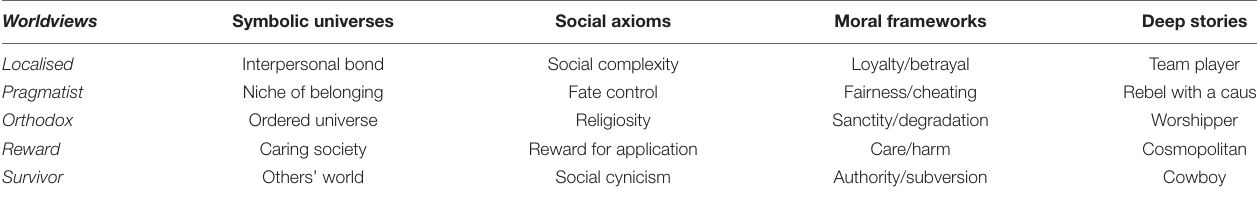
TABLE 1 | Syncretic conceptualisation of